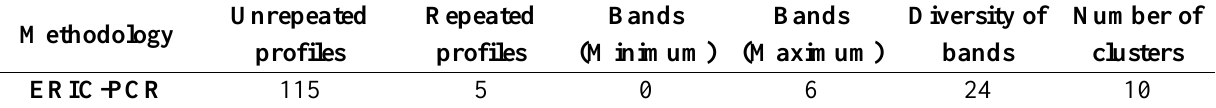
Table 1. Identification of Profiles, Bands and Clusters in Association with Escherichia coli Strains